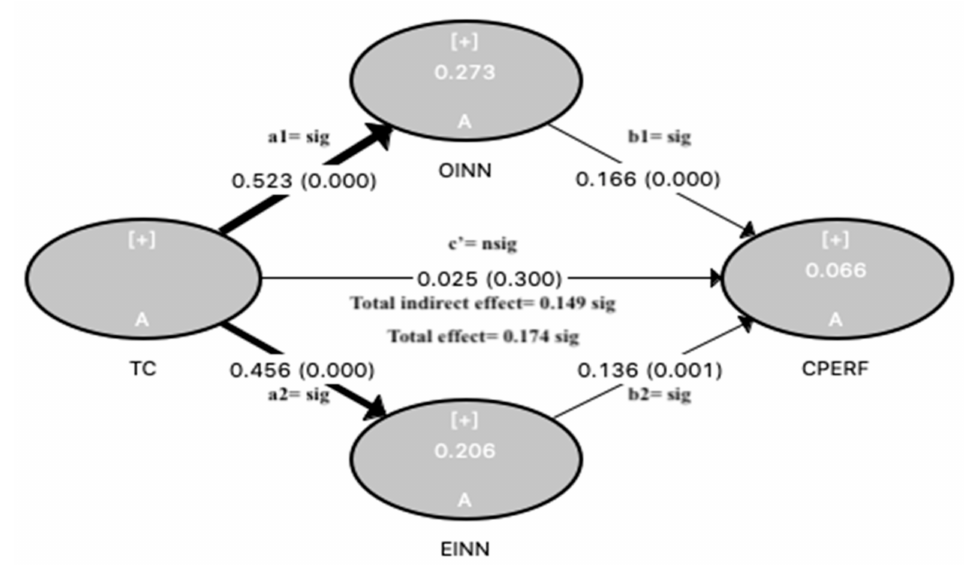
Figure 3. Nomogram of the study (multiple mediation).